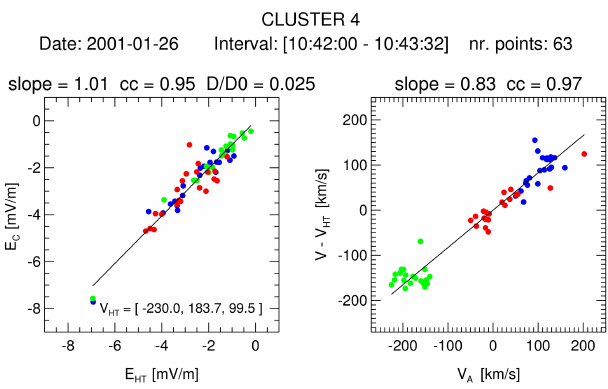
Figure 8. HT and Walén analysis for the 26 January 2001 crossing, with the same layout as Fig.